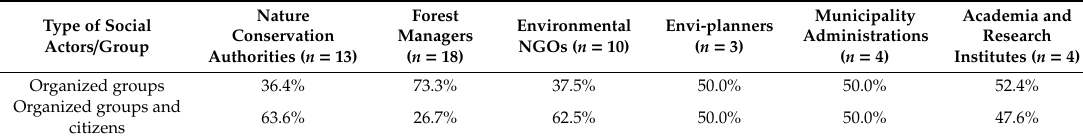
Table 4. Appropriate level of inclusiveness of organized groups and citizens in the implementation of the Natura 2000